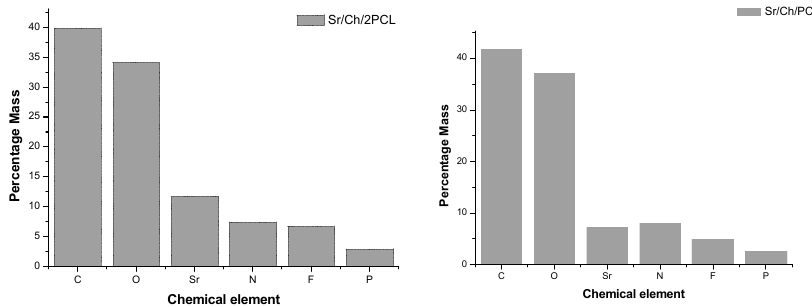
Figure 1. EDS chemical element percent mass of Sr/Ch/2PCL and Sr/Ch/PCL dried samples. Ch: chitosan; PCL: poly( ε -caprolactone).